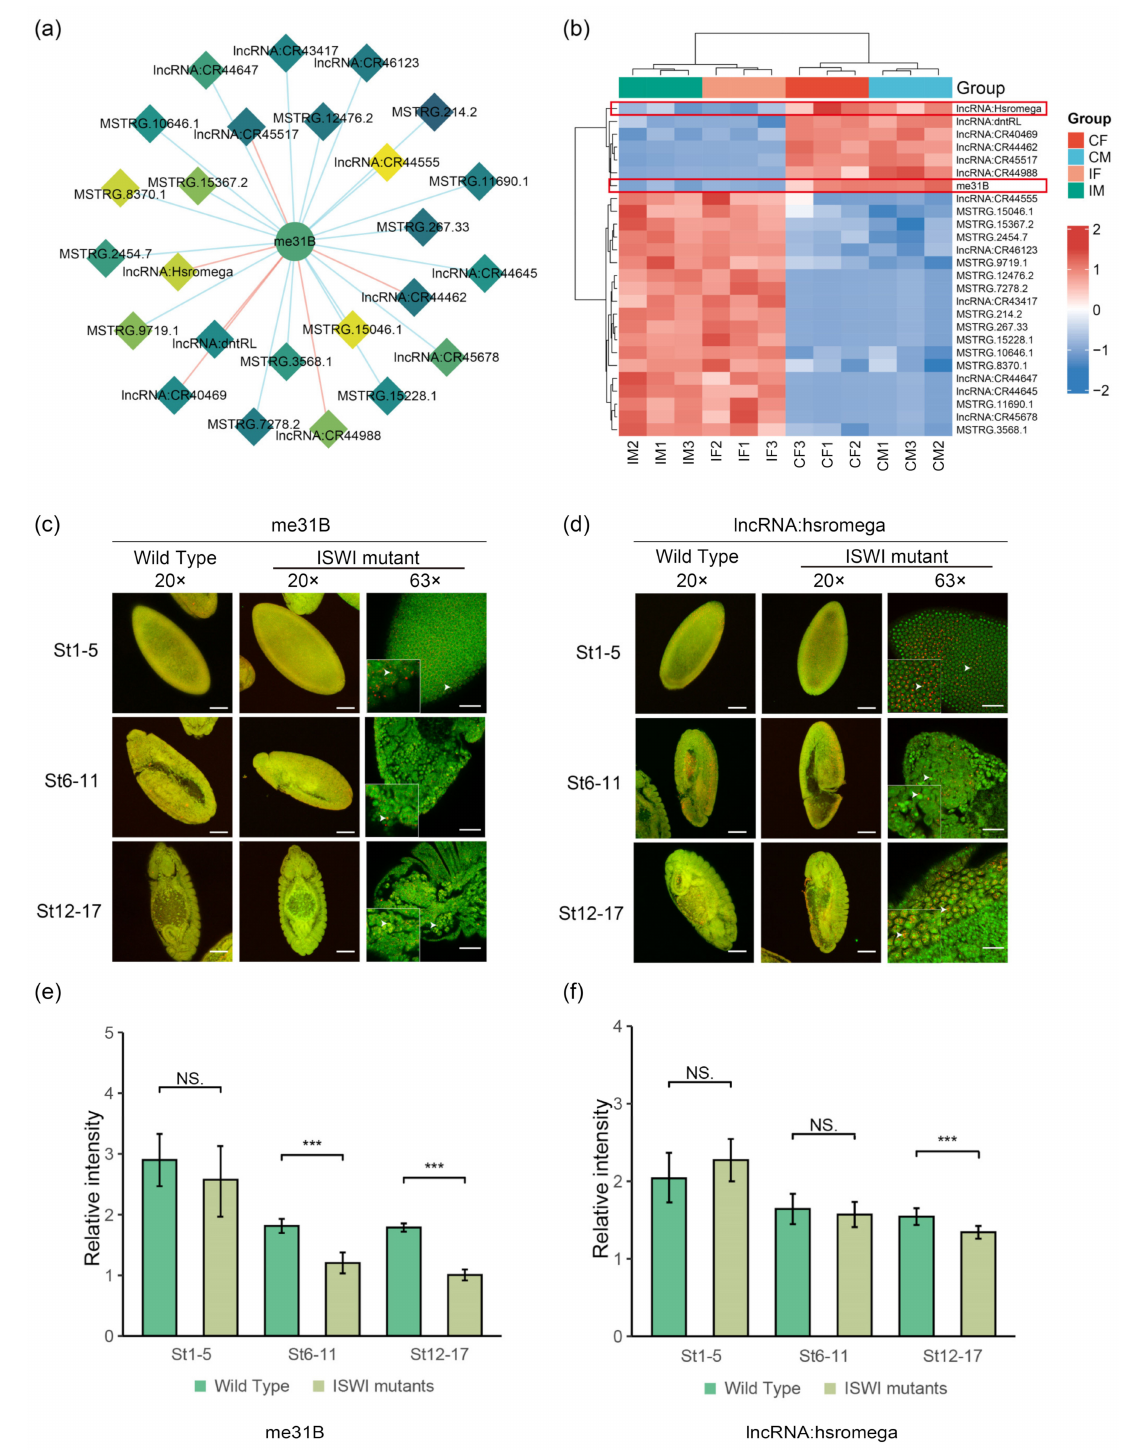
Figure 5. A possible interactor of DE-lncRNAs associated with ovarian development- me31B . ( a ) Net- work diagram of me31B and co- expressed lncRNAs. The diamond nodes represent lncRNAs, and the circle nodes represent mRNAs. The darker the color of node, the higher the degree of connection (the more co-expressed interactions). The red edge represents a positive correlation and the blue edge represents a negative correlation. ( b ) Clustering heat map of me31B and lncRNA expression levels in Figure 5a. ( c , d ) TSA-FISH results of me31B ( c ) and lncRNA: hsromge ( d ) in wild-type and mutant Drosophila embryos. 20 × : Scale bars, 80 µ m. The red pseudo-color is the signal from Probe and the green pseudo-color is the signal from nucleus. The genotype of the sample is shown in the